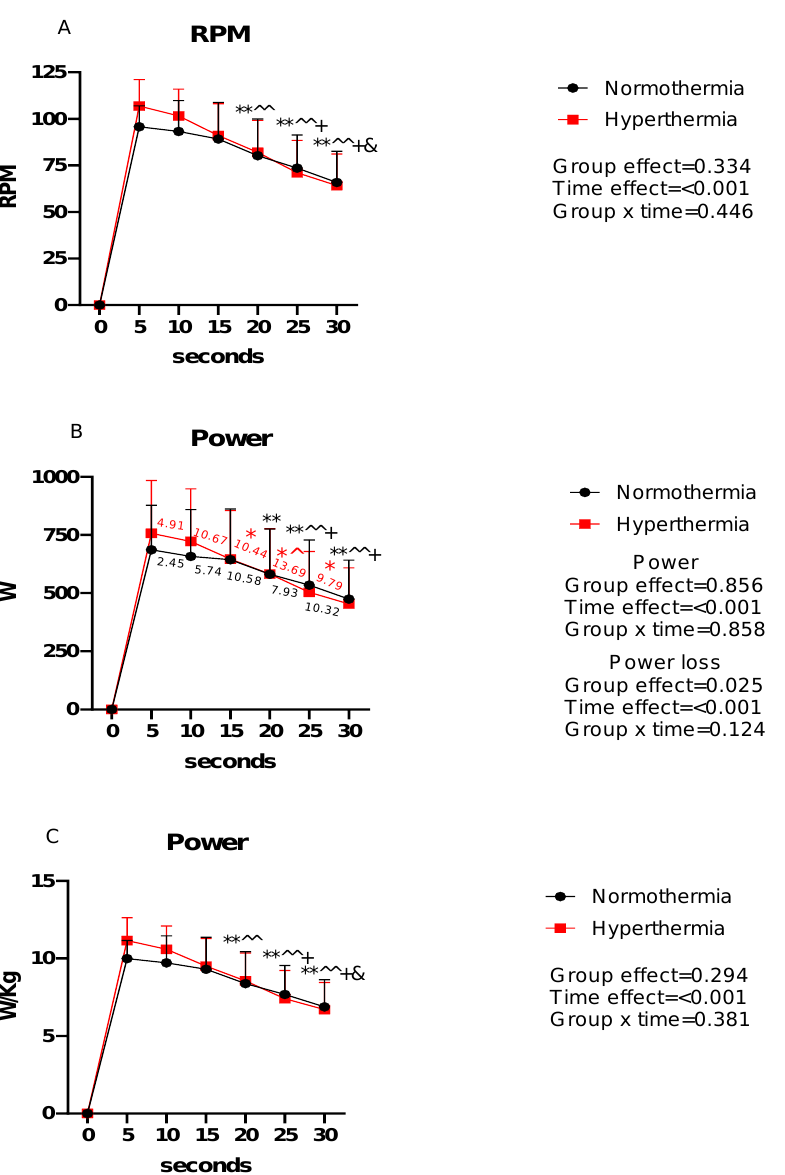
Figure 2. Evolution of RPM and power during the test. ( A ): evolution of RPM throughout the test; ( B ): evolution of absolute power during the test; ( C ): evolution of power values relative to weight throughout the test; RPM: revolution per minutes; red number: power losses of the hyperthermia group with respect to 5 ″ later; black number: power losses of the hyperthermia group with respect to 5 ″ later; * p < 0.05; ** p < 0.01 differences with respect to 5 ″ ; ^ p < 0.05, ^^ p < 0.01 differences with respect to 10 ″ ; + p < 0.05 differences with respect to 15 ″ ; and & p < 0.05 differences with respect to 20 ″ .